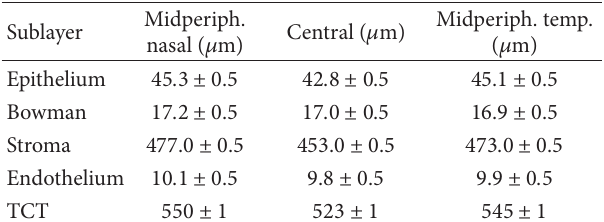
Table 1: Mid-peripheral nasal, central, and mid-peripheral tempo- ral corneal sublayers thickness estimation obtained averaging the respective evaluations performed on 156 images (right eye). The Total corneal thickness (TCT) value is calculated as the sum of all